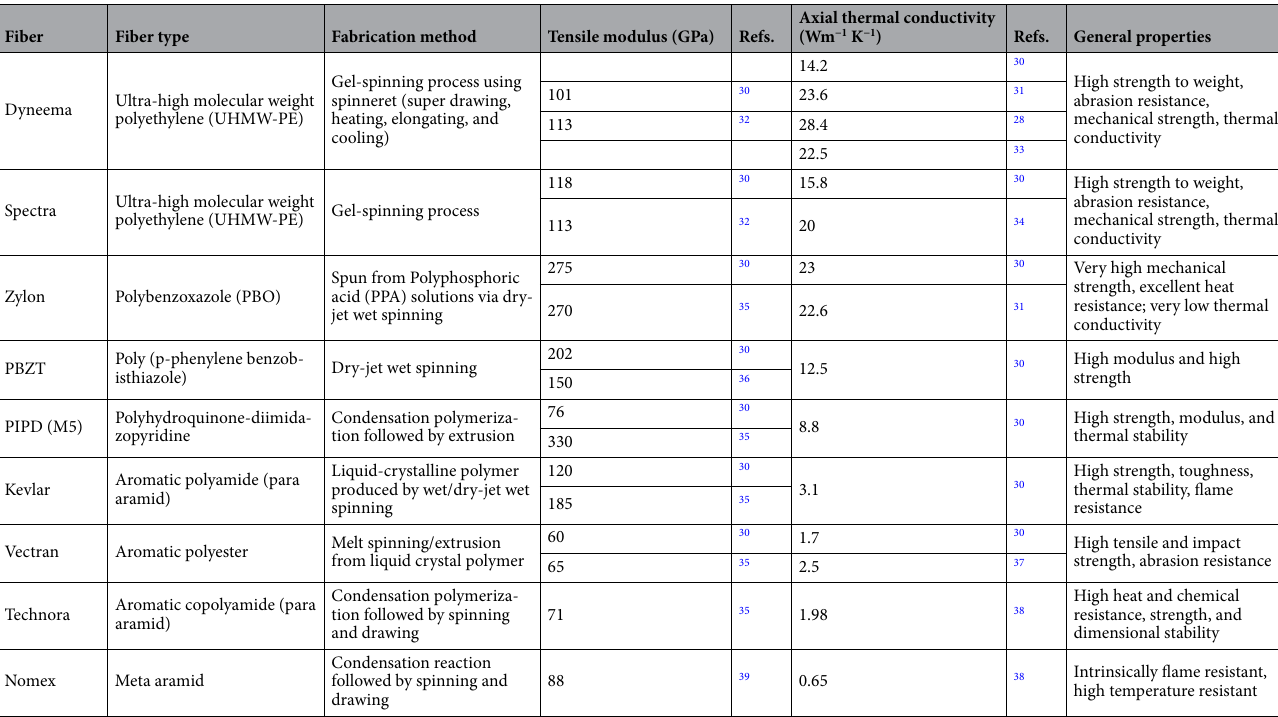
Table 1. Details of the different high-performance polymer fibers (shown in Fig.